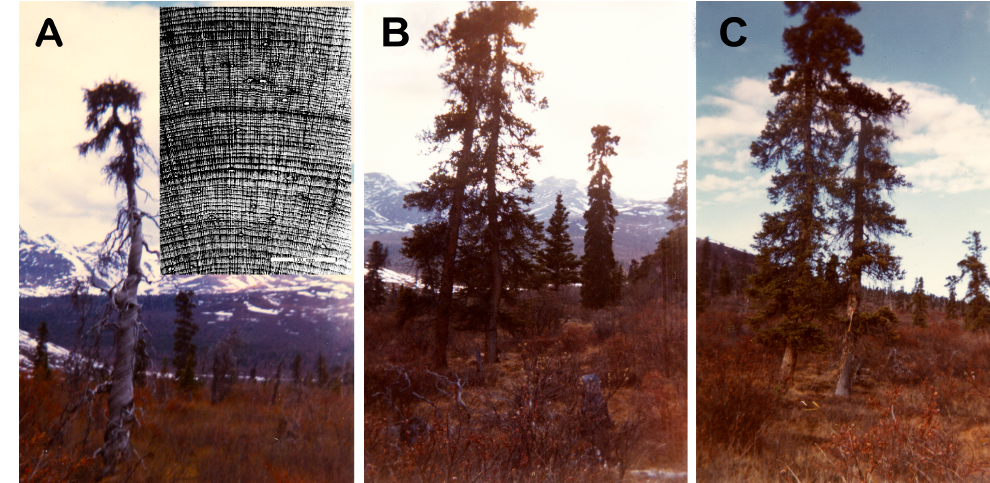
Figure 9. Early August 1974. Three on-site photographs taken at 1250 m ± 20 m asl; ( A ) looking west with East Fork Creek in the valley bottom at left; inset: xylem layers in a cross section of a branch from the foreground tree (see [6]). ( B ) Looking west; ( C ) looking east; the axe handle = 60 cm.